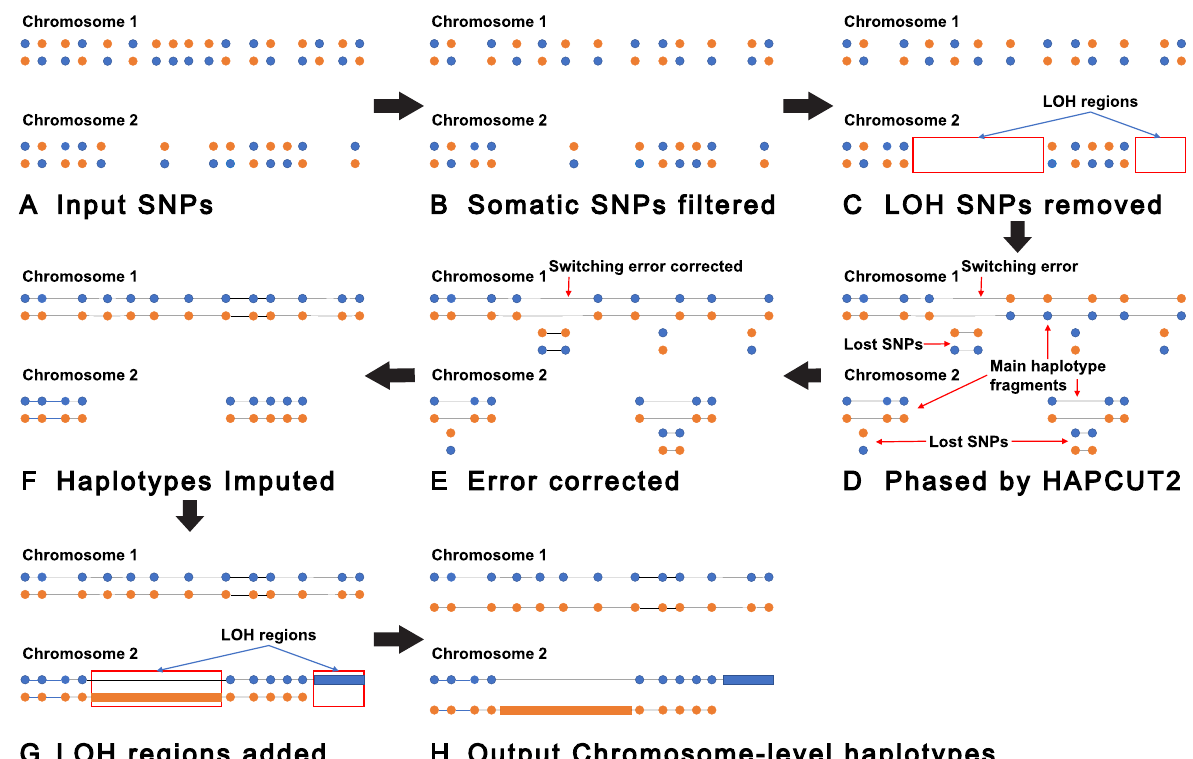
Figure 1. Pipeline of HiCancer. ( A ) The input unphased SNPs. Each blue-orange pair represents the two alleles of one SNP. Blue and orange represent two haplotypes of each chromosome. ( B ) Somatic SNPs are detected and removed from the input SNPs. ( C ) LOH regions are detected and SNPs in LOH regions are removed. ( D ) Pre-processed SNPs in non-LOH regions are phased by HapCut2. After phasing, in addition to main haplotype fragments, a large number of small fragments with one or a few SNPs exist. And main haplotype fragments contain some switching errors. ( E ) Switching errors are corrected. ( F ) The small haplotype fragments are merged into main haplotype fragments. ( G ) The sequences in LOH regions and the haplotyes in non-LOH regions are connected to chromosome-level haplotypes. ( H ) The final output chromosome-level